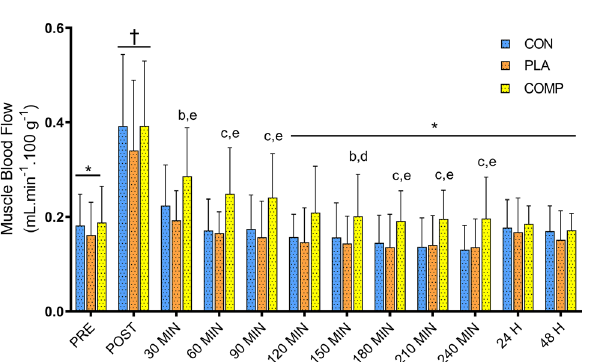
Figure 2. Common femoral vein markers of venous return for CON, PLA and COMP conditions. Markers measured include ( a ) cross-sectional area (CSA), ( b ) mean flow velocity (V mean ), ( c ) peak flow velocity (V peak ) and ( d ) venous blood flow. Time points are before exercise (PRE), immediately post-exercise (POST), 4 h recovery (30–240 min), and 24 and 48 h post-exercise. All data presented as mean ± SD. † Significant time effect as compared with all other time points. *Significant time effect as compared with 30 min post-exercise. # Significant time effect as compared with 60 min post-exercise. a Small effect as compared with CON. b Medium effect as compared with CON. c Large effect as compared with CON. e Medium effect as compared with PLA. f Large effect as compared with PLA.